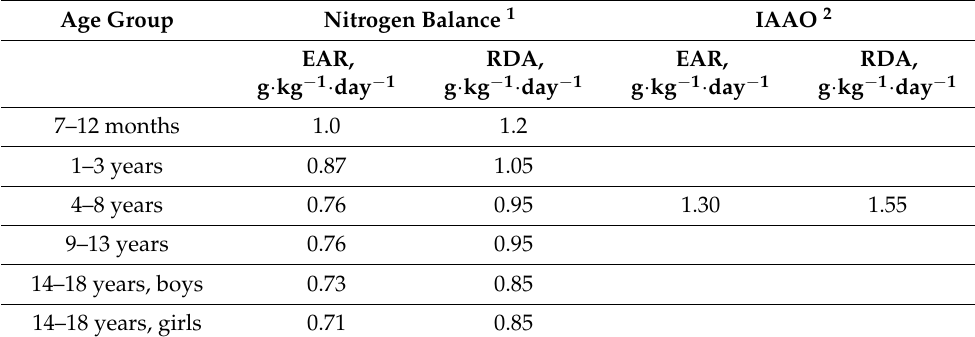
Table 1. Current requirement estimates by age and sex for